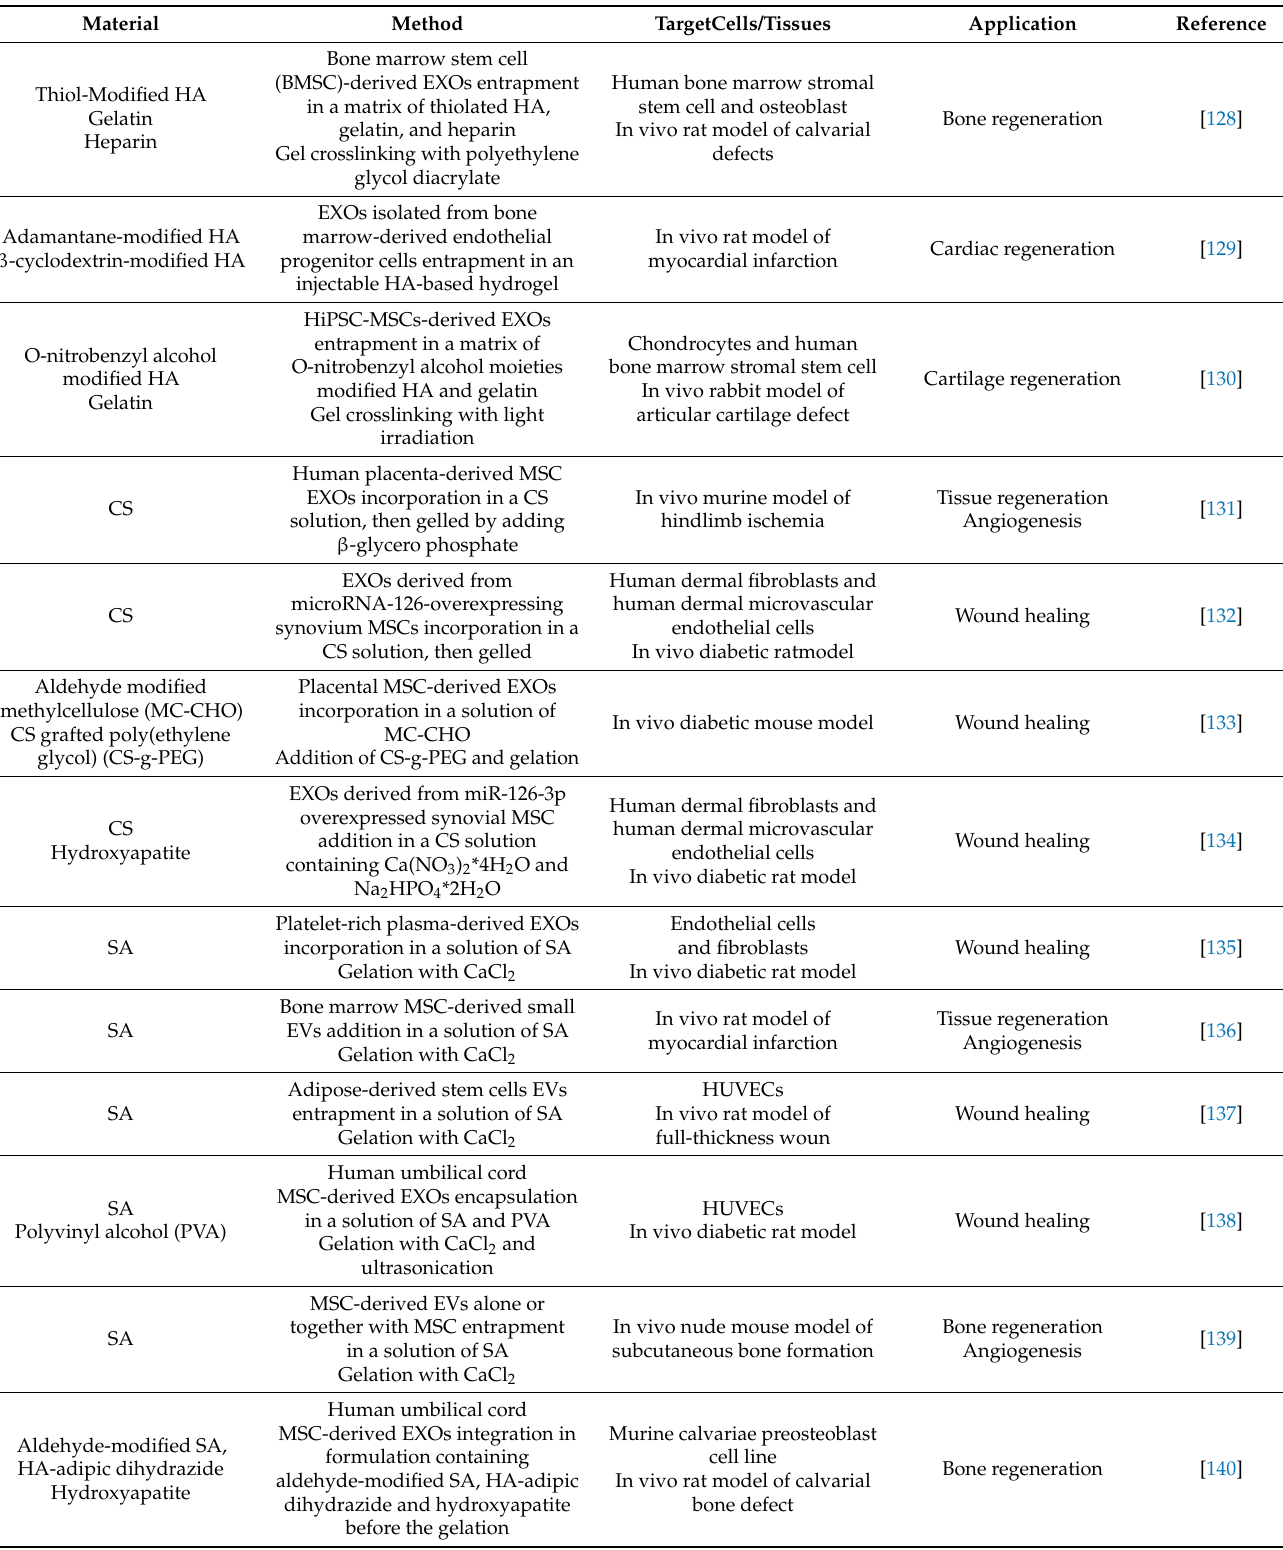
Table 3. Polysaccharide-based in situ gelling systems for sustained delivery of